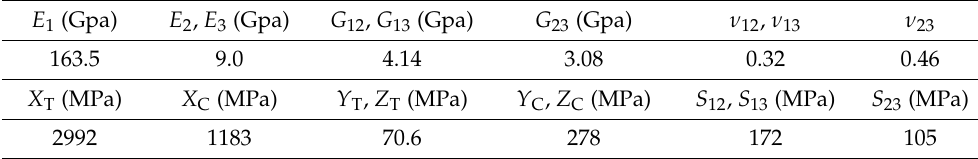
Table 1. Basic mechanical properties of T800/epoxy